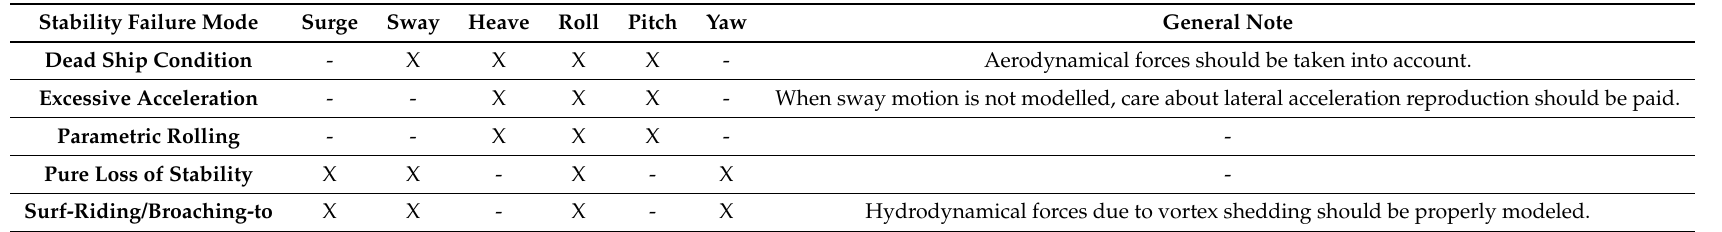
Table 1. Degrees of freedom required in the simulation of particular stability failure